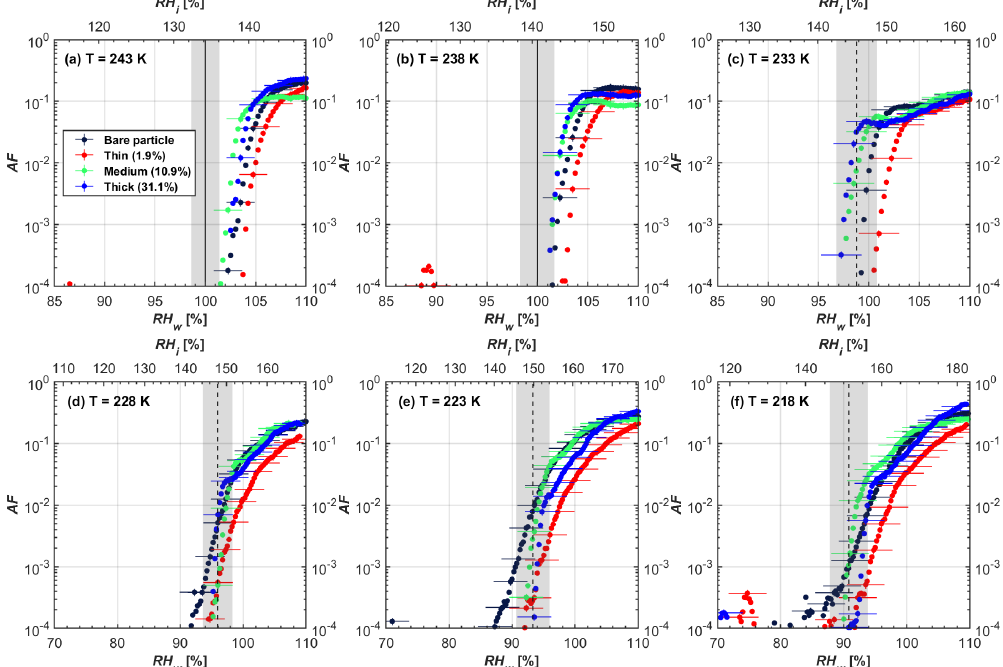
Figure 5. AF as a function of RH at the given temperatures for 400nm mCASTblack soot particles. Black solid lines represent water satura- tion conditions according to Murphy and Koop (2005). Black dashed lines denote the expected RH values for solution droplet homogeneous freezing at T < HNT (Koop et al., 2000). The grey-shaded area shows the possible RH variation and uncertainty in HINC for the calculated water saturation and homogeneous freezing conditions. The percentages represent the H 2 SO 4 coating